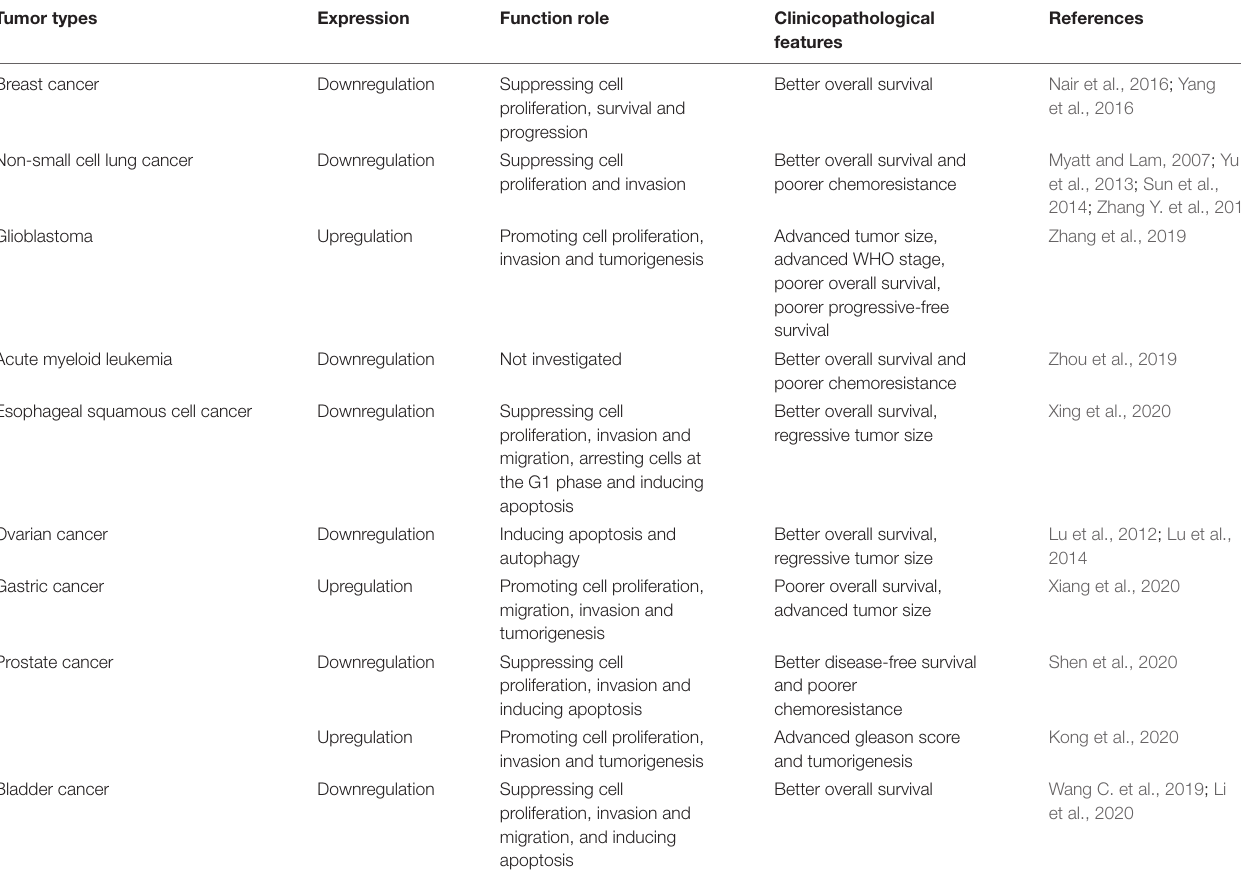
TABLE 1 | Functional characterization and clinical significance of circ-Foxo3 in human